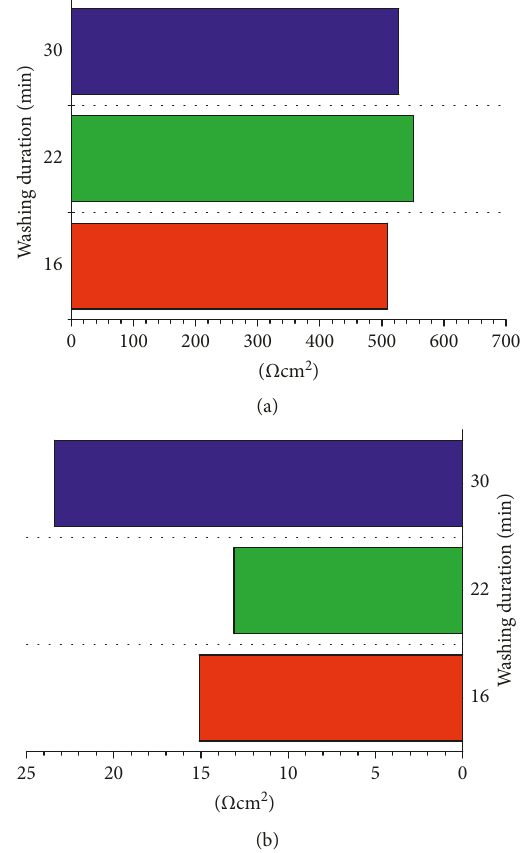
Figure 5: Summary of absolute values of shunt resistance ( R and specific series resistance ( R s )